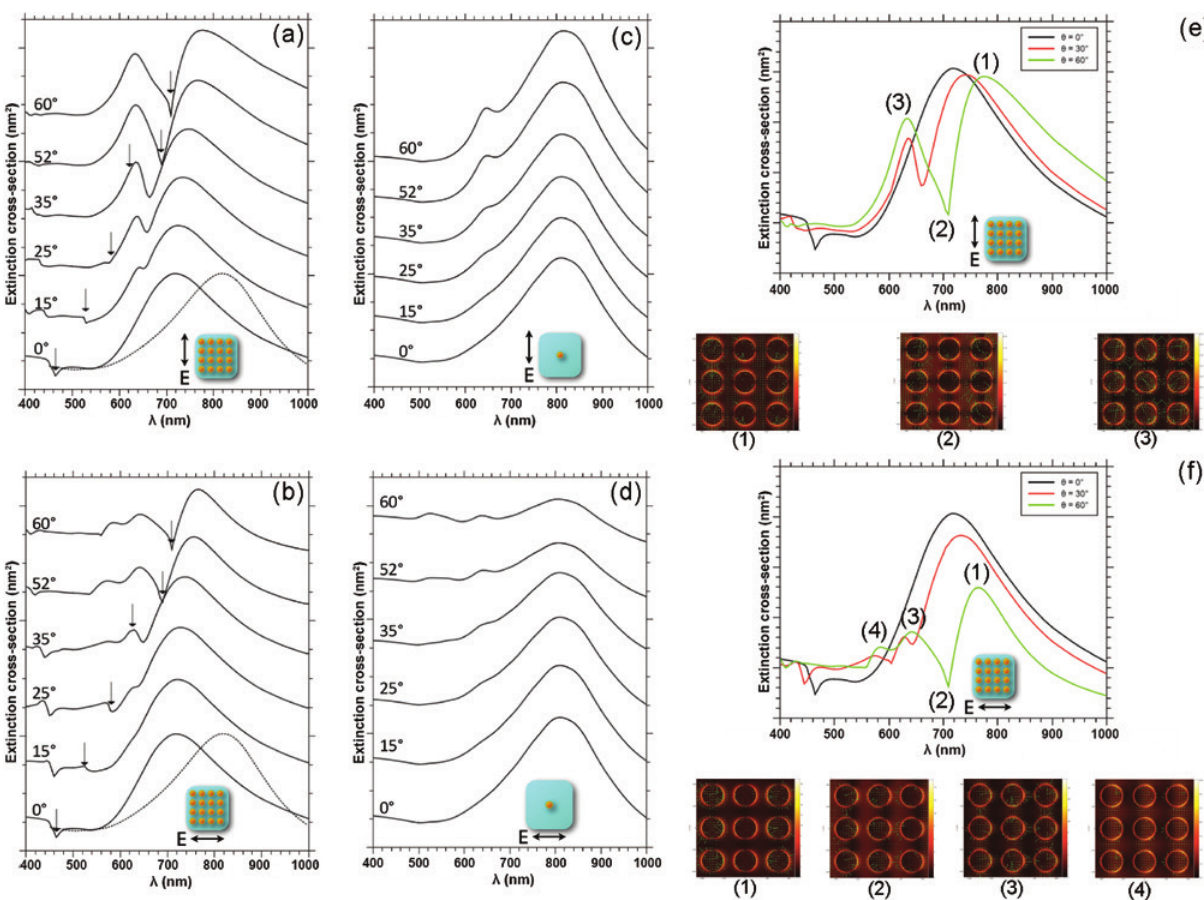
Figure 6: Numerical simulations of the extinction spectra as a function of the wavelength in the VIS-NIR range for different incidence angles of excitation. TE (A) and TM (B) excitation polarization in case of an array of nano-cylinders; TE (C) and TM (D) excitation polarization in case of a single nano-cylinder; description of resonance modes and their evolution for different incidence angles of excitation and corresponding field maps calculated at the bottom of the nano-cylinders in case of TE (E) and TM (F) excitation